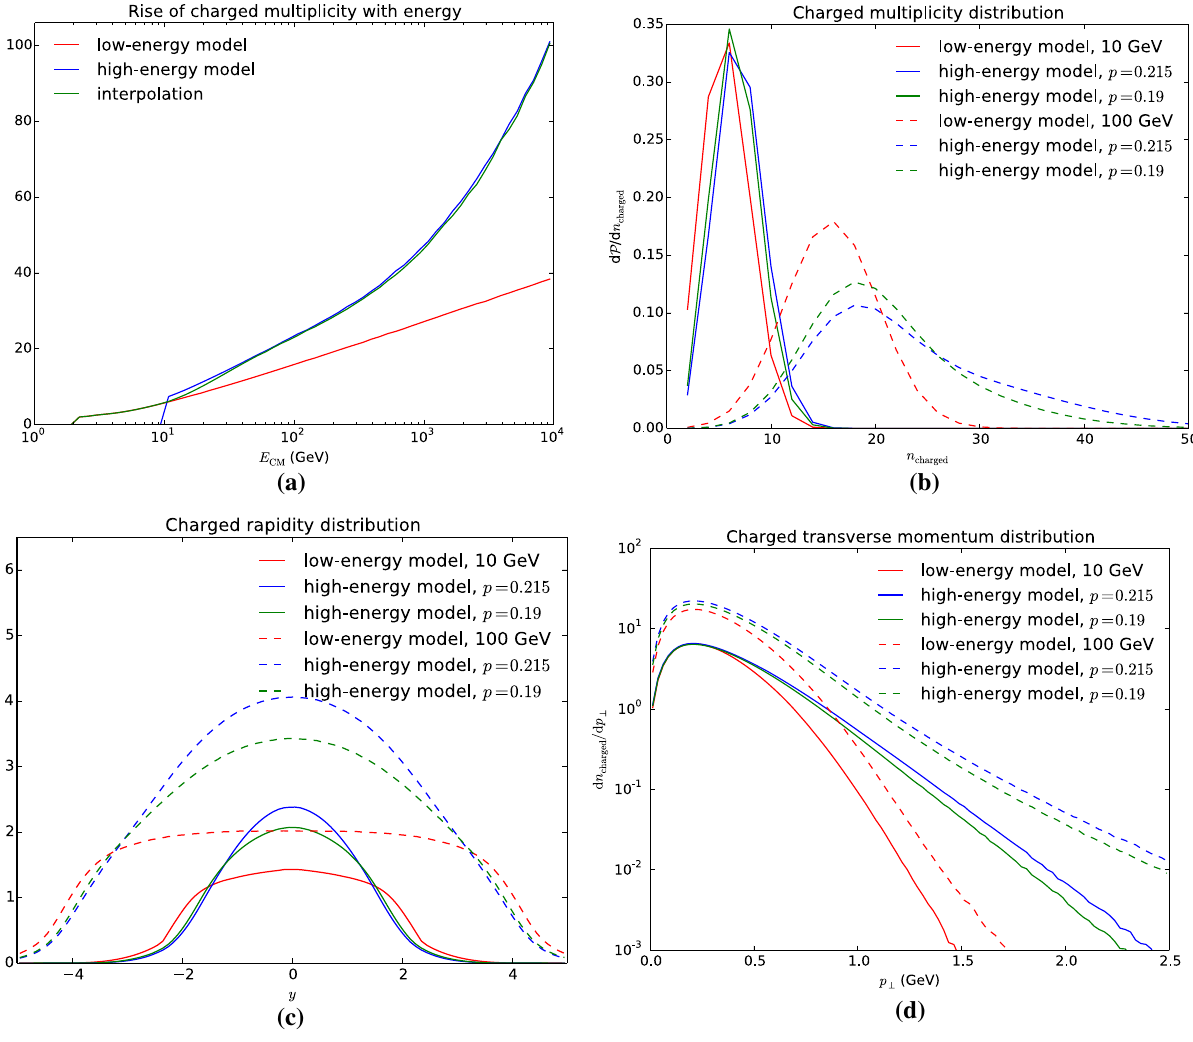
Fig. 7 a Energy dependence of the average charged multiplicity in nondiffractive pp collisions. b – d Comparison of charged multiplicity, rapidity and transverse momentum distributions for 10 and 100 GeV nondiffractive pp